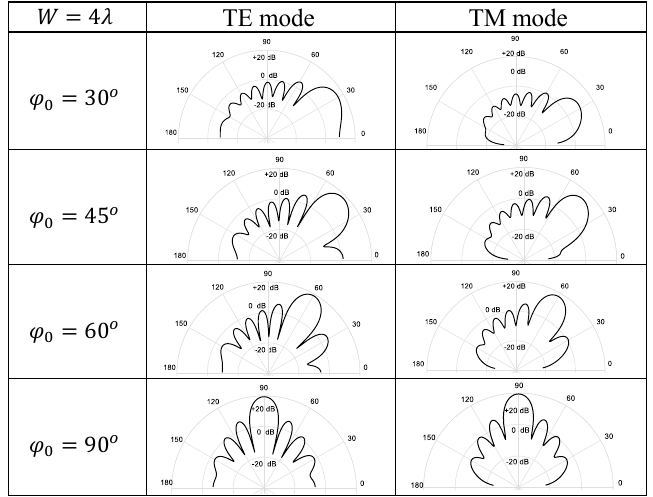
= 90 (cid:135) and 𝜑 = A A